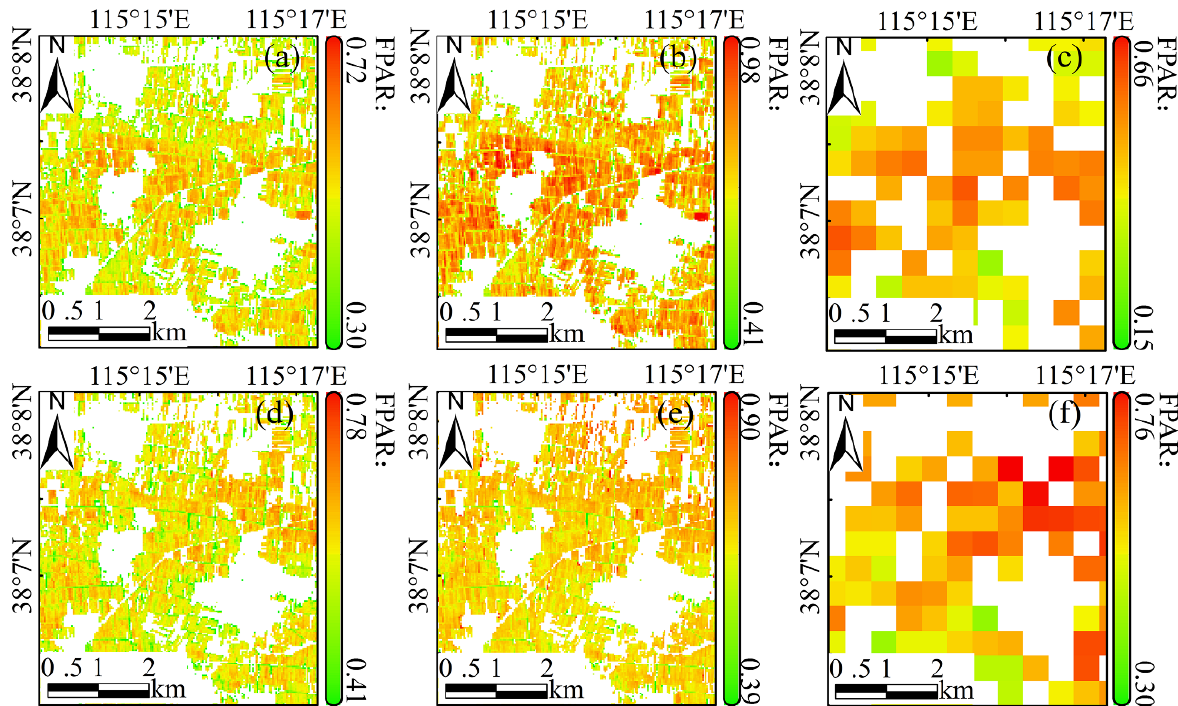
Figure 15. Spatial distribution of seasonal average FPAR of different crops. ( a – c ) Seasonal average FPAR of winter wheat based on NDVI red-edge , NDVI and MODIS FPAR product. ( d – f ) Seasonal average FPAR of summer maize based on SR red-edge , NDVI and MODIS FPAR product.